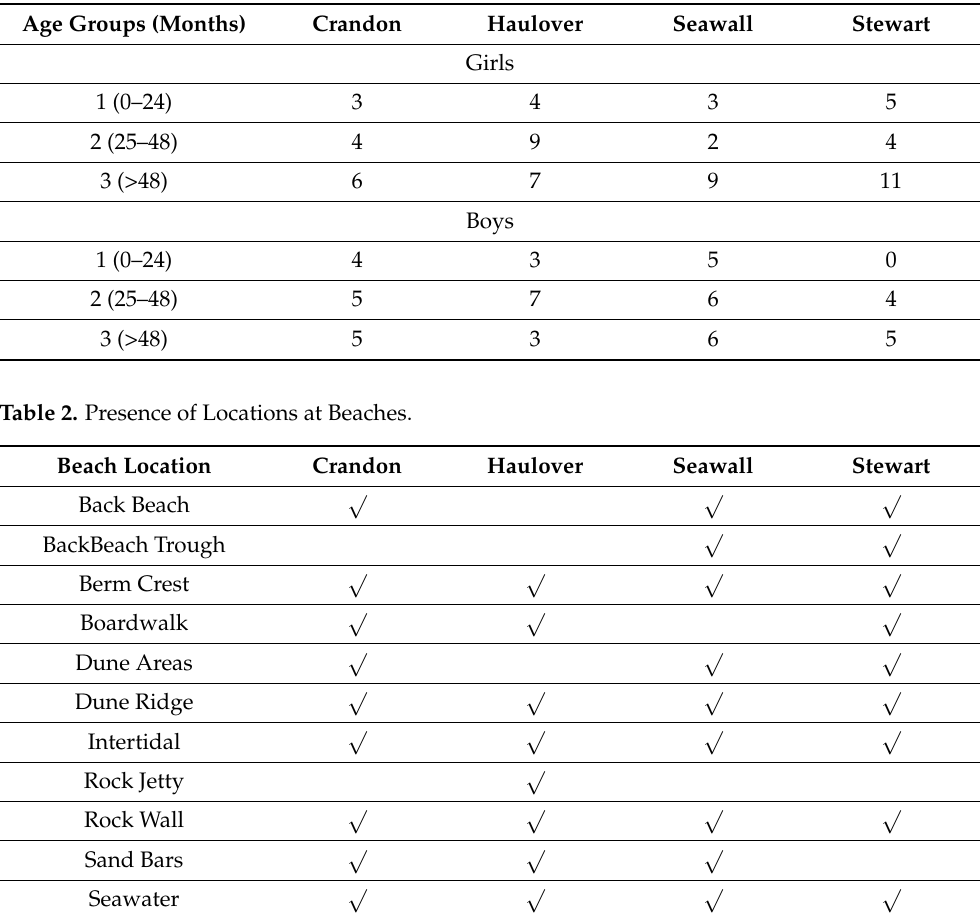
Table 1. Number, Sex and Age Group of Children by Beach.